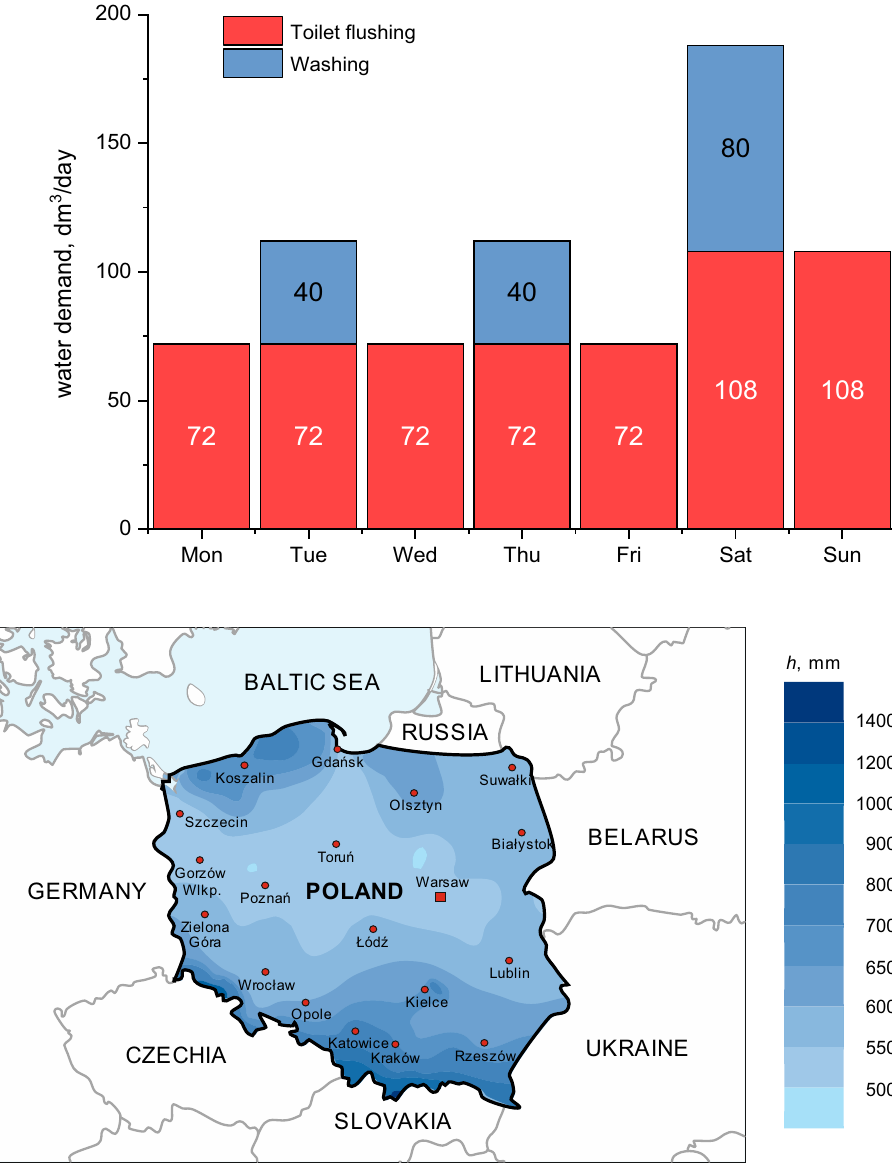
Fig. 2 The weekly water demand profile for toilet flush- ing and washing, dm 3 /day